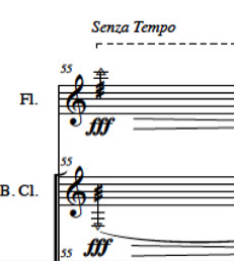
Figure 13. Indeterminate pitch range, played Senza